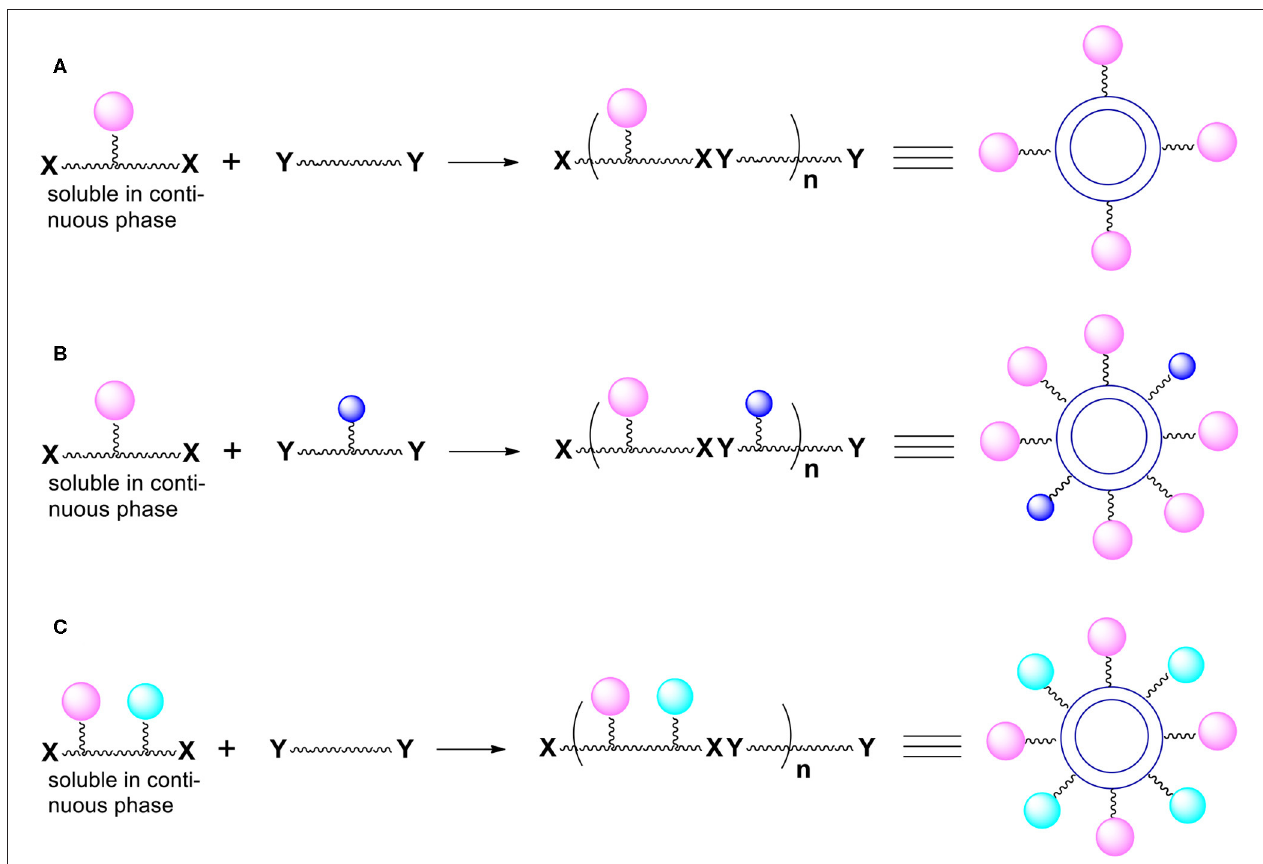
FIGURE 1 | Introduction of functional groups onto the external surface of reservoir nano/microcapsules. (A) Additional groups (pink spheres) are present only in monomer molecules that are soluble in the continuous phase. (B) Additional groups (pink and blue spheres) derive from both bi(poly)functional monomers. (C) Additional groups (pink and green spheres) derive from one of the monomers (the one that is soluble in the continuous phase).